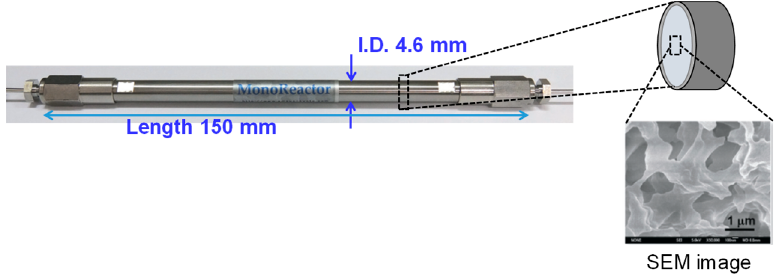
Figure 3. Monolithic microreactor (MR) and SEM image of the monolith structure inside the reactor.